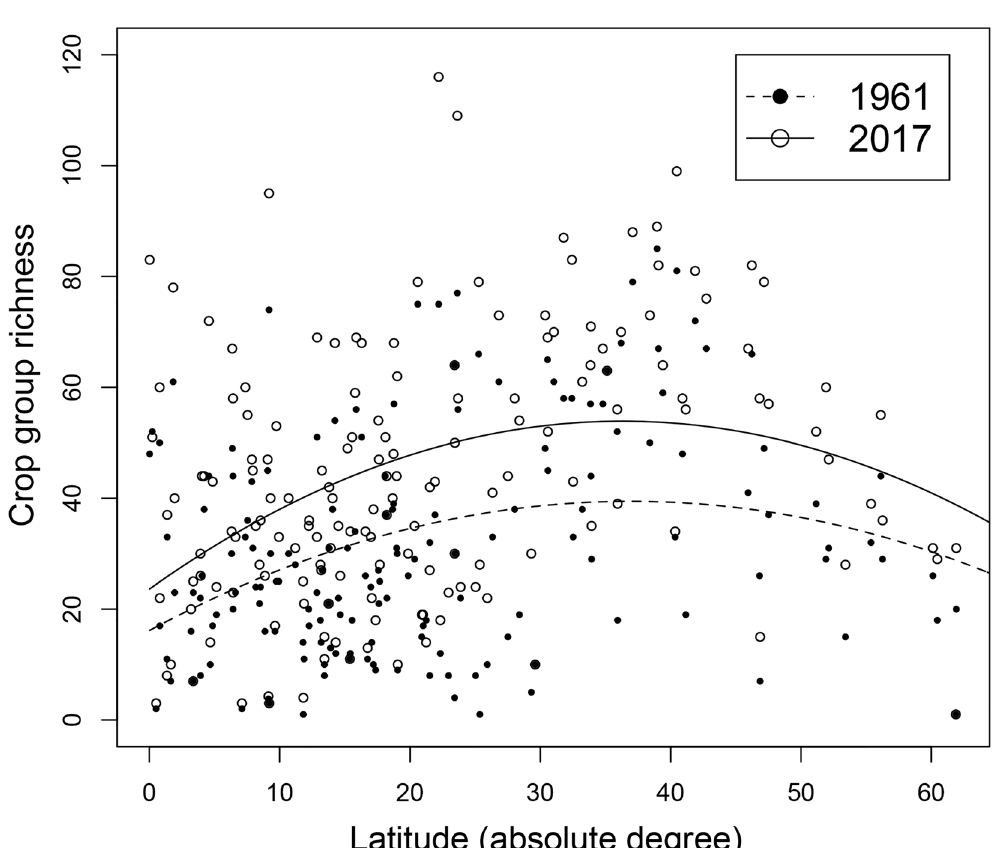
Figure 3. Latitudinal patterns in crop group richness across 164 countries in 1961 and 2017. Only countries with data from both years are included in this analysis. Trend lines represent results from linear models (including a 2nd-order polynomial term) that predict crop group richness as a function of latitude (and latitude 2 ) in 1961 (dashed line, filled circles) and 2017 (solid line, open circles). Complete diagnostics for both models are presented in Table